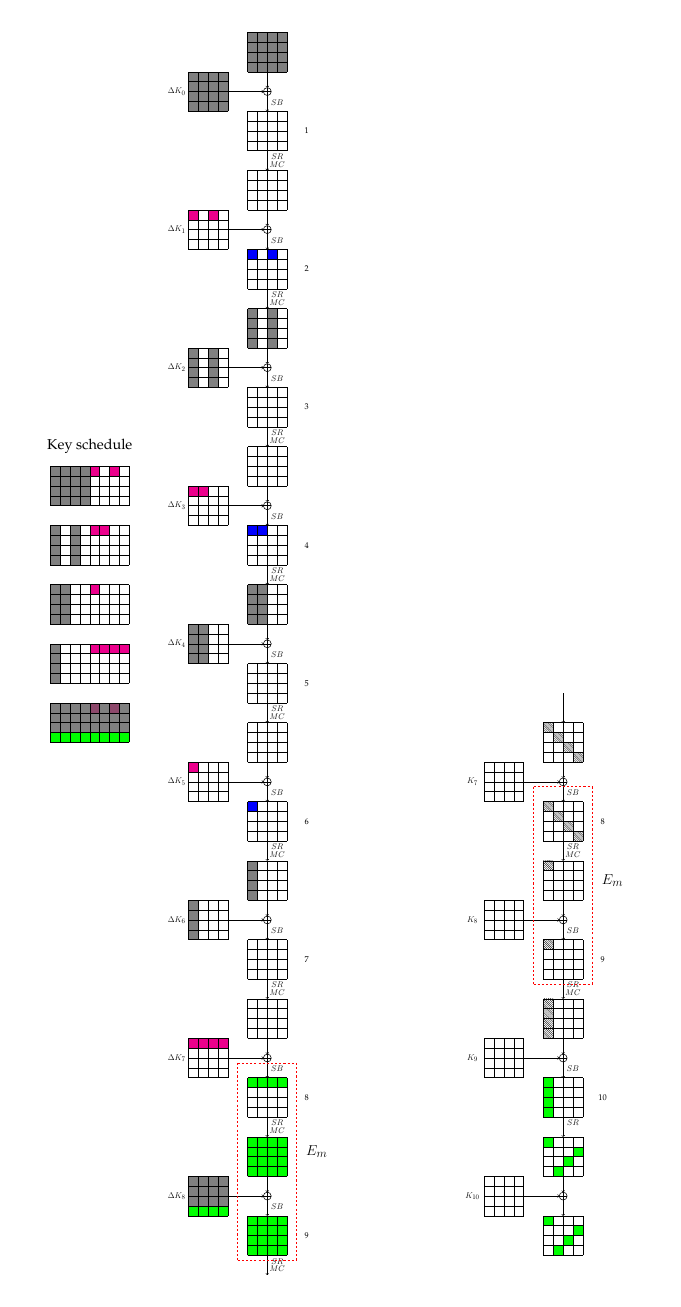
Figure 14: Boomerang attack on 10-round AES -256. The red rectangles depict the locations of 2-round boomerang